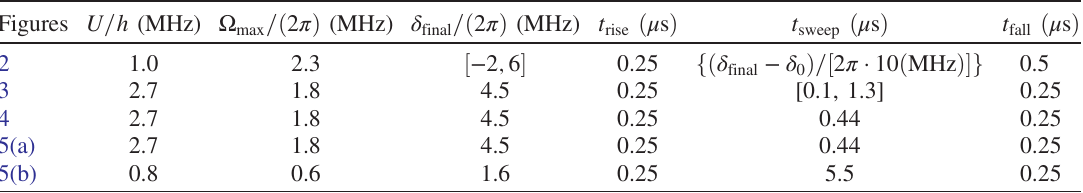
TABLE I. Experimental parameters used for the data presented in the main